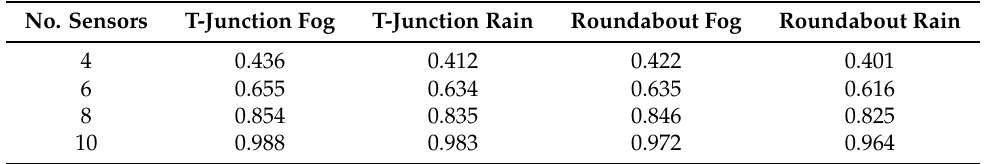
Table 7. Outcome of the supplementary assessment process.